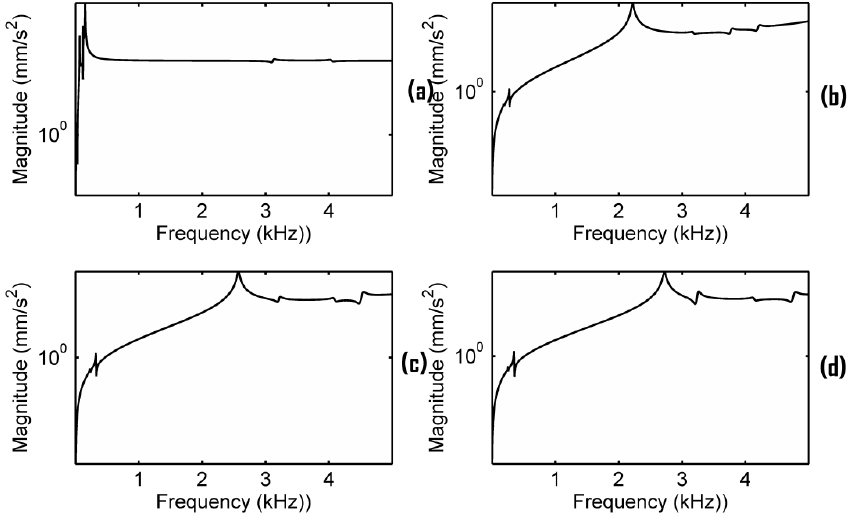
Figure 10. Frequency responses of the plate solid bridge in Figure 1b with the damping ratio 0.7% critical when EFS1 = 0.01 N/mm 3 and ( a ) EFS2 using the estimate